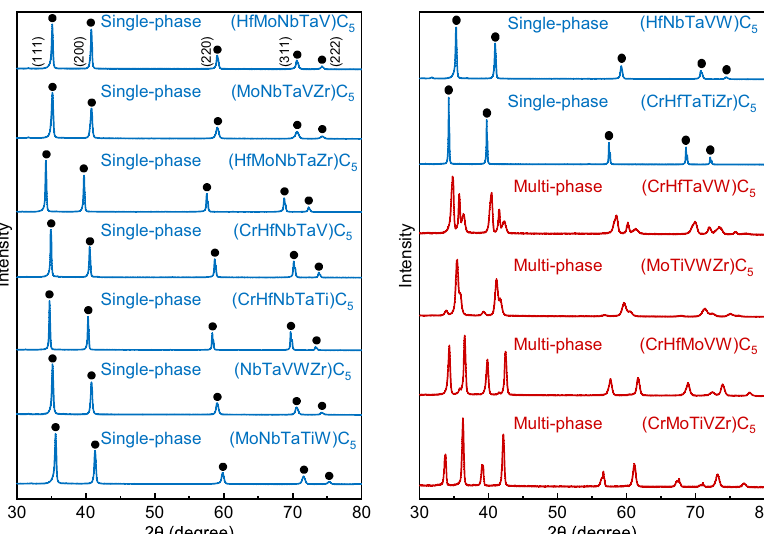
Fig. 4 X-ray diffraction patterns for experimentally validated HECCs. Nine materials including (HfMoNbTaV)C 5 , (MoNbTaVZr)C 5 , (HfMoNbTaZr)C 5 , (CrHfNbTaV)C 5 , (CrHfNbTaTi)C 5 , (NbTaVWZr)C 5 , (MoNbTaTiW)C 5 , (HfNbTaVW)C 5 , and (CrHfTaTiZr)C 5 are single-phase HECCs with one FCC phase; others are observed with multiple FCC peaks. The HECCs shown in the fi gure are in the order of the averaged single- phase probability based on the current ML models.